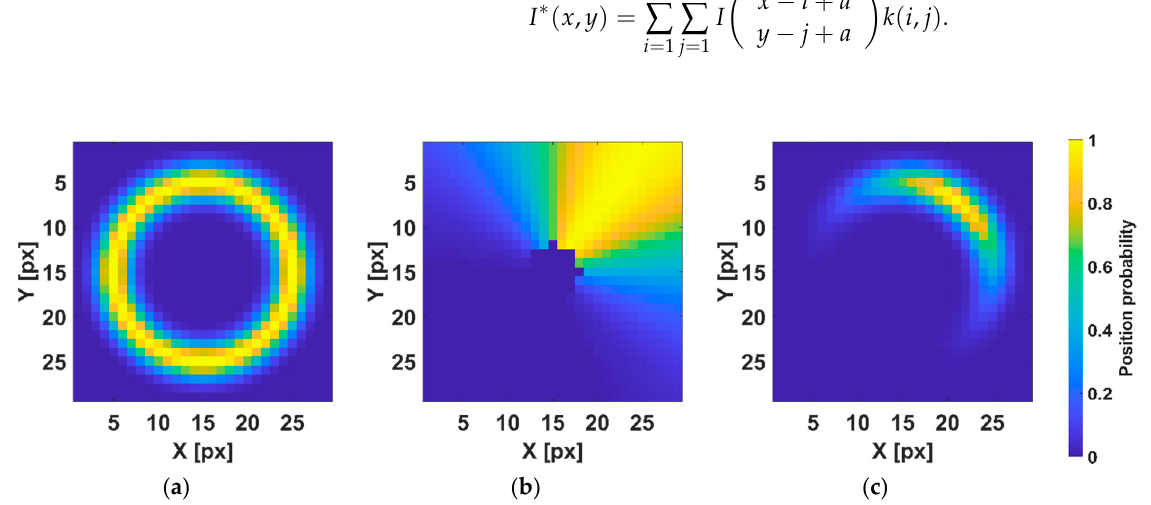
Figure 4. Pedestrian dead reckoning maps: ( a ) ring of the step size distribution; ( b ) heading estimation; ( c ) resulting probability distribution of one step.